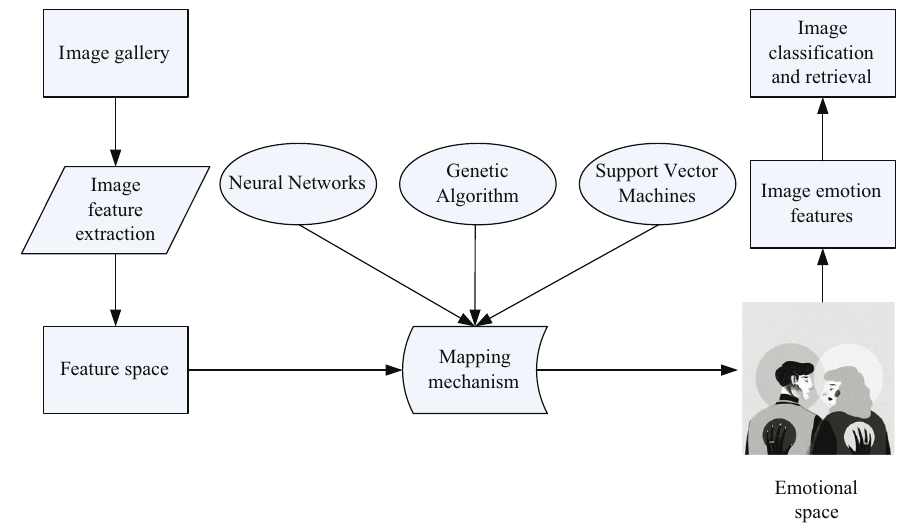
Figure 1: Image semantic extraction